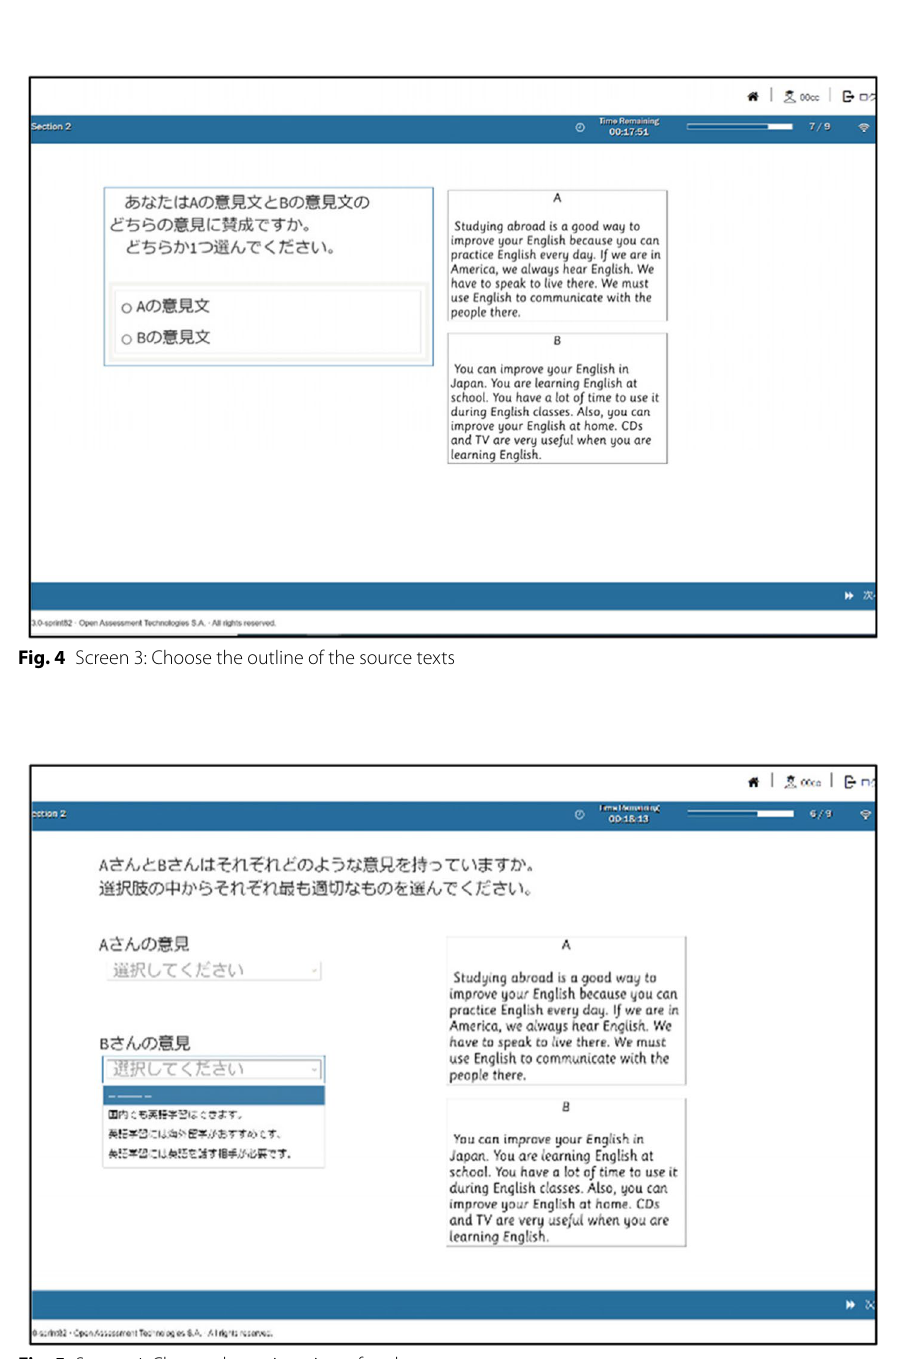
Fig. 5 Screen 4: Choose the main points of